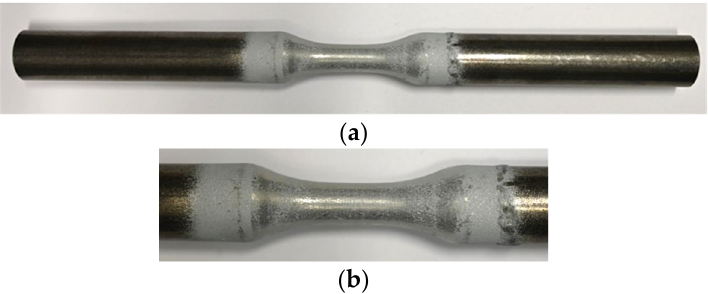
Figure 5. Macro images of ZnAl-coated and machine hammer-peened (III) specimen, ( a ) overview, ( b ) detail of gauge length.